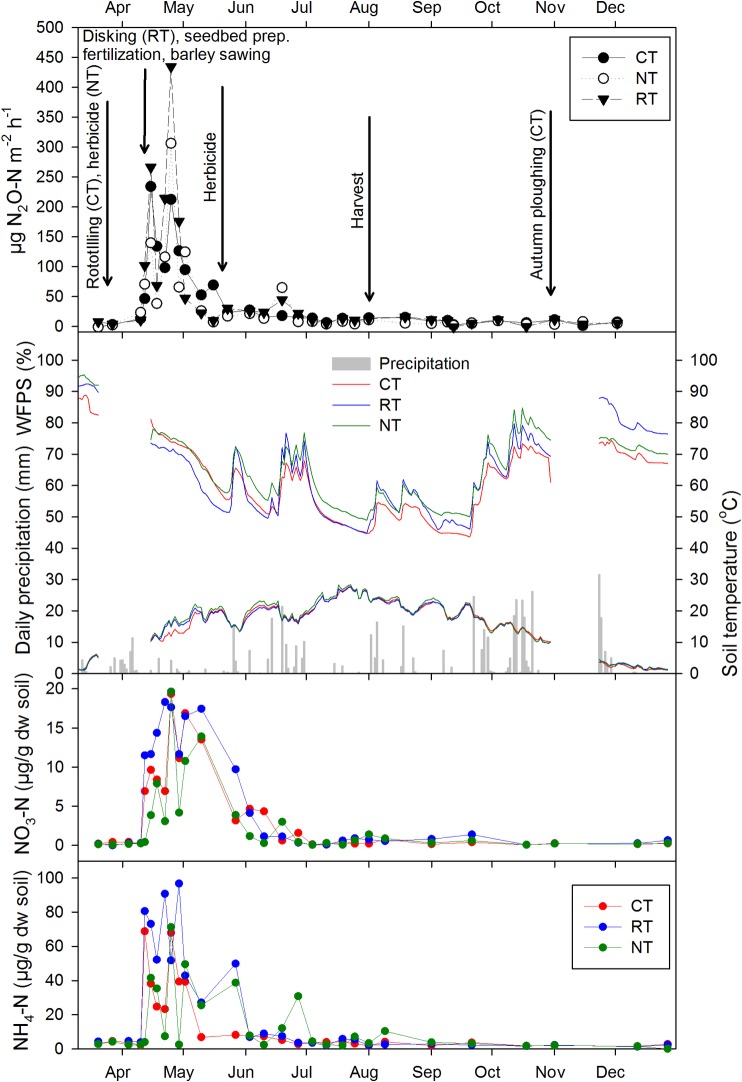
a Mean N2O emissions (n = 4), b daily precipitation, mean soil temperature and moisture in 5 cm depth, c Soil NO3- and d soil NH4+ concentrations in 0–15 cm depth CT, NT and RT treatments in 2015. Error bars are omitted to maintain readability.